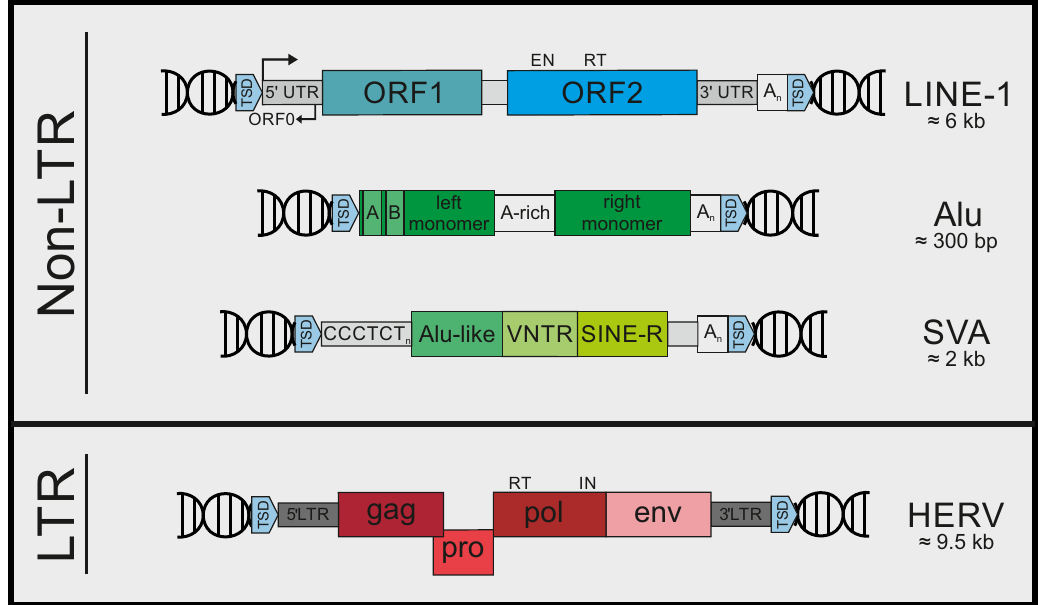
Figure 1. Types of retrotransposons in humans. Non-long terminal repeat (LTR) retroelements include long interspersed element (LINE)-1 elements, Alu elements, and short-interspersed element (SINE)-variable tandem repeats (VNTR)-Alu (SVA) elements. Full-length LINE-1 elements are approximately 6 kb in length and encode two open-reading frames (ORF1 and ORF2) in sense orientation, flanked by untranslated regions (UTR). LINE-1 also contains an antisense open reading frame (ORF0) within the 5 (cid:48) UTR, in which the internal promoter is located. The 3 (cid:48) UTR includes a poly(A) signal. The 300 bp Alu elements are composed of a left and right monomer separated by an adenosine-rich sequence (A-rich). The left monomer contains an internal RNA polymerase III promoter (A and B boxes). The structure of SVA elements starts with a (CCCTCT) n hexamer repeat region, which is followed by an Alu-like domain, a variable tandem repeats (VNTR) region, a human endogenous retrovirus (HERV)-K-derived SINE-R domain, and a poly(A) signal. LTR retrotransposons mainly include HERVs. HERV sequences consist of two LTRs flanking four open reading frames, coding for structural proteins ( gag ), protease ( pro ), polymerase and reverse transcriptase ( pol ), and the envelope protein ( env ), which is mostly dysfunctional. Abbreviations: TSD, target site duplication; EN, endonuclease; RT, reverse transcriptase; gag, group-specific antigen; IN,